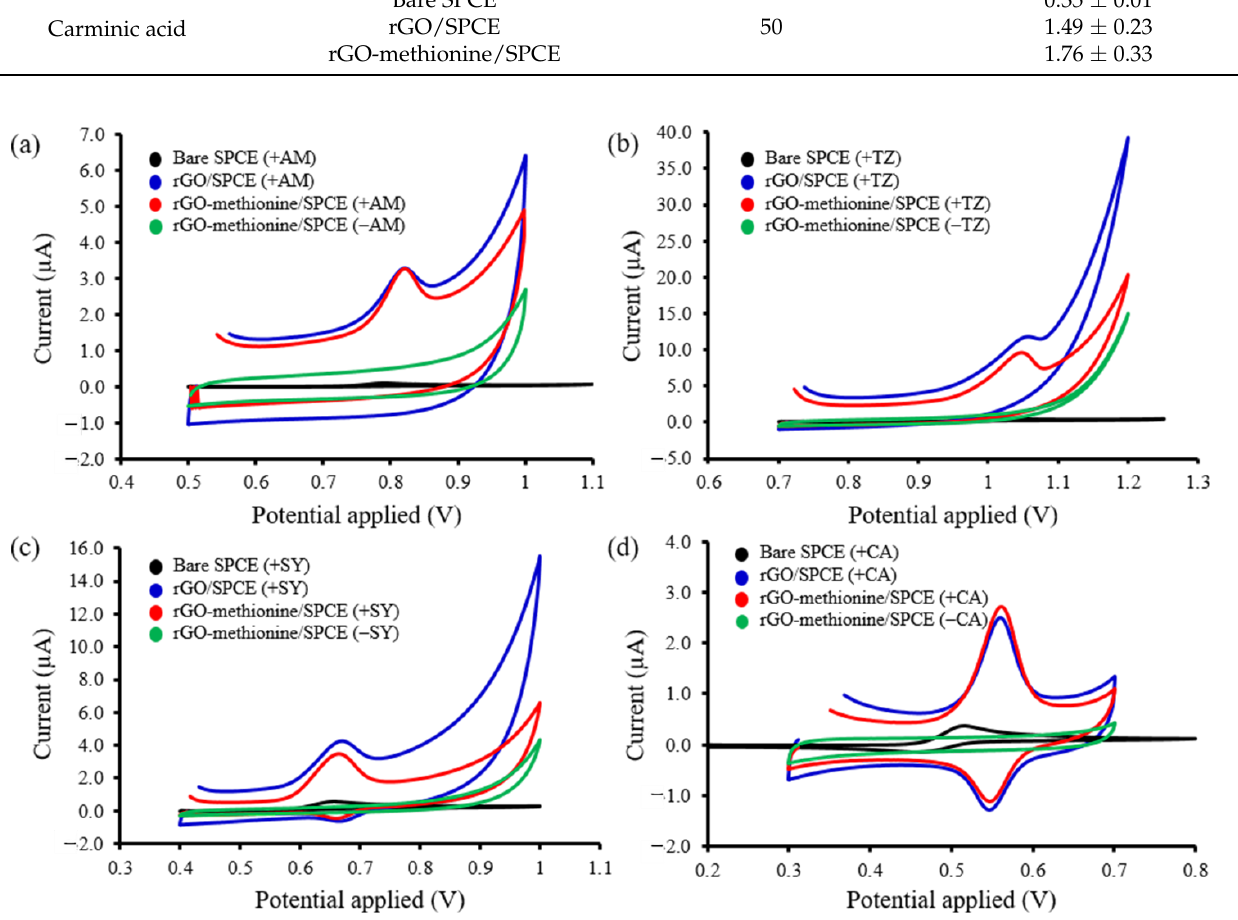
Figure 3. CV curves of 0 and 10 μM amaranth ( a ), 0 and 50 µM Tartrazine ( b ), 0 and 50 µM sunset yellow ( c ), 0 and 50 µM carminic acid ( d ) on bare SPCE (black), rGO/SPCE (blue), and rGO-methionine modified SPCE (red) at scan rate 20 mv / s . Table 1. Electrochemical response of amaranth, tartrazine, sunset yellow, and carminic acid on bare SPCE, rGO / SPCE, and rGO - methionine / SPCE .